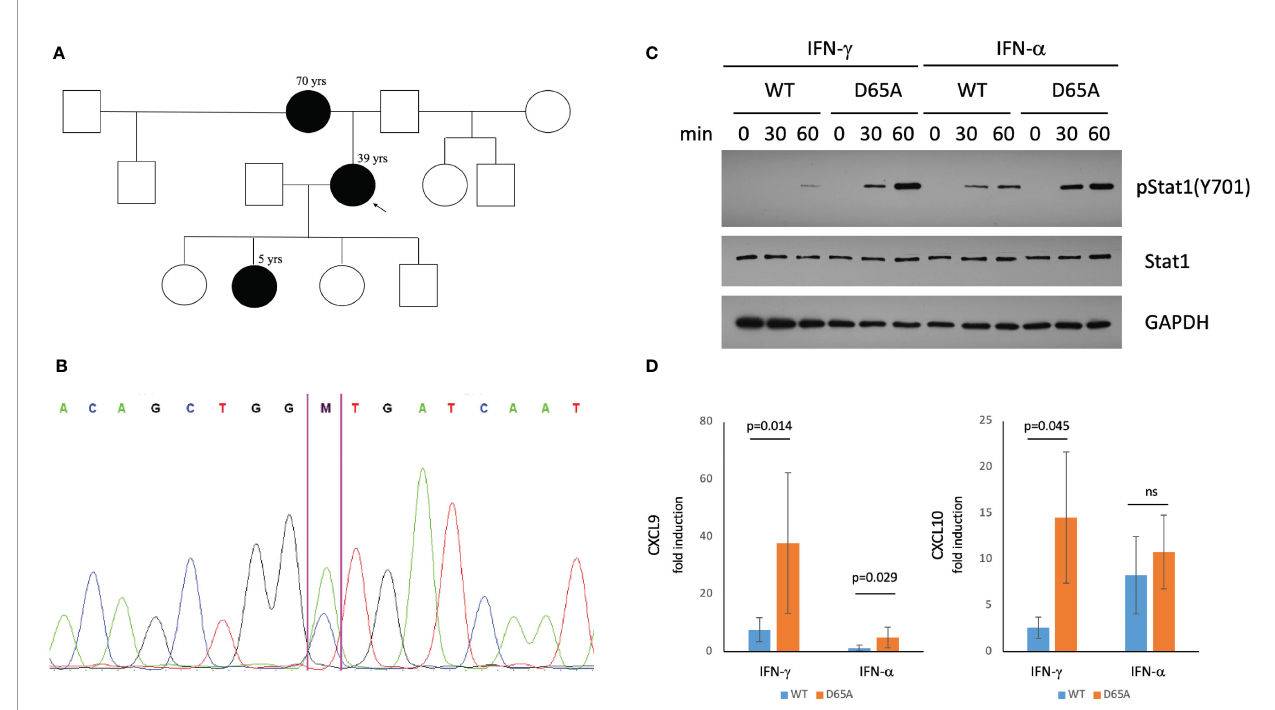
FIGURE 2 | A STAT1 mutation identi fi ed in our patients causes STAT1 gain-of-function. (A) Pedigree of a three-generational family affected by STAT1 mutation (black). The proband (arrow) suffered from eosinophilic esophagitis and chronic mucocutaneous Candidiasis (CMCC). Her mother had a history of life-long esophagitis and CMCC. The proband ’ s daughter was affected by CMCC, recurrent acute otitis media, and atopic dermatitis. (B) Con fi rmatory sequencing of the STAT1 gene in our patients revealed a heterozygous mutation, c.194A>C (p.D65A) in the N-terminal domain. (C) Immunoblotting of STAT1-null U3A cells transfected with either wildtype or D65A STAT1 demonstrated normal total levels of STAT1 in the mutant, with elevated levels of pSTAT1 (Tyr701) following stimulation with either IFN- g or IFN- a . (D) Quantitative real-time PCR demonstrated increased fold induction of CXCL9 in D65A U3A cells after stimulation with either IFN- g or IFN- a , with increased fold induction of CXCL10 following stimulation with IFN- g . ns, not signi fi